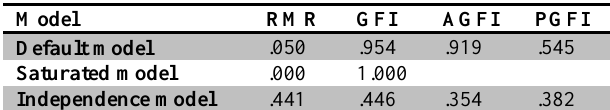
Table 6: Baseline comparison Model RMR GFI